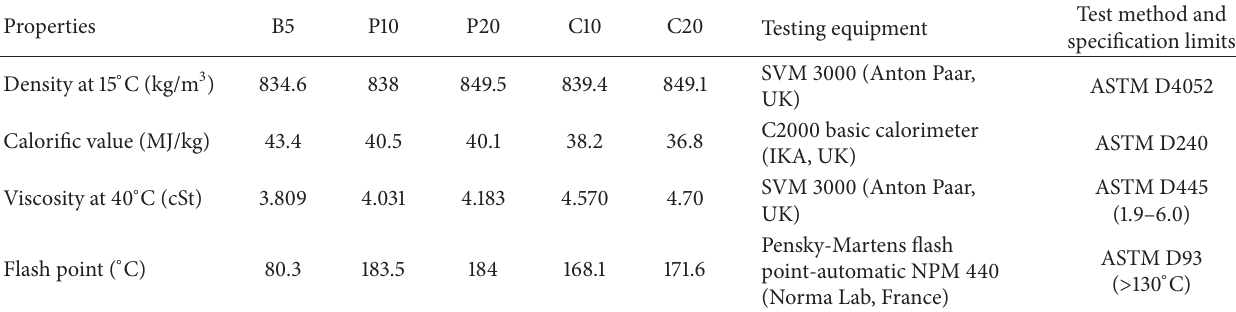
Table 2: Measured fuel properties of all tested fuel blends.